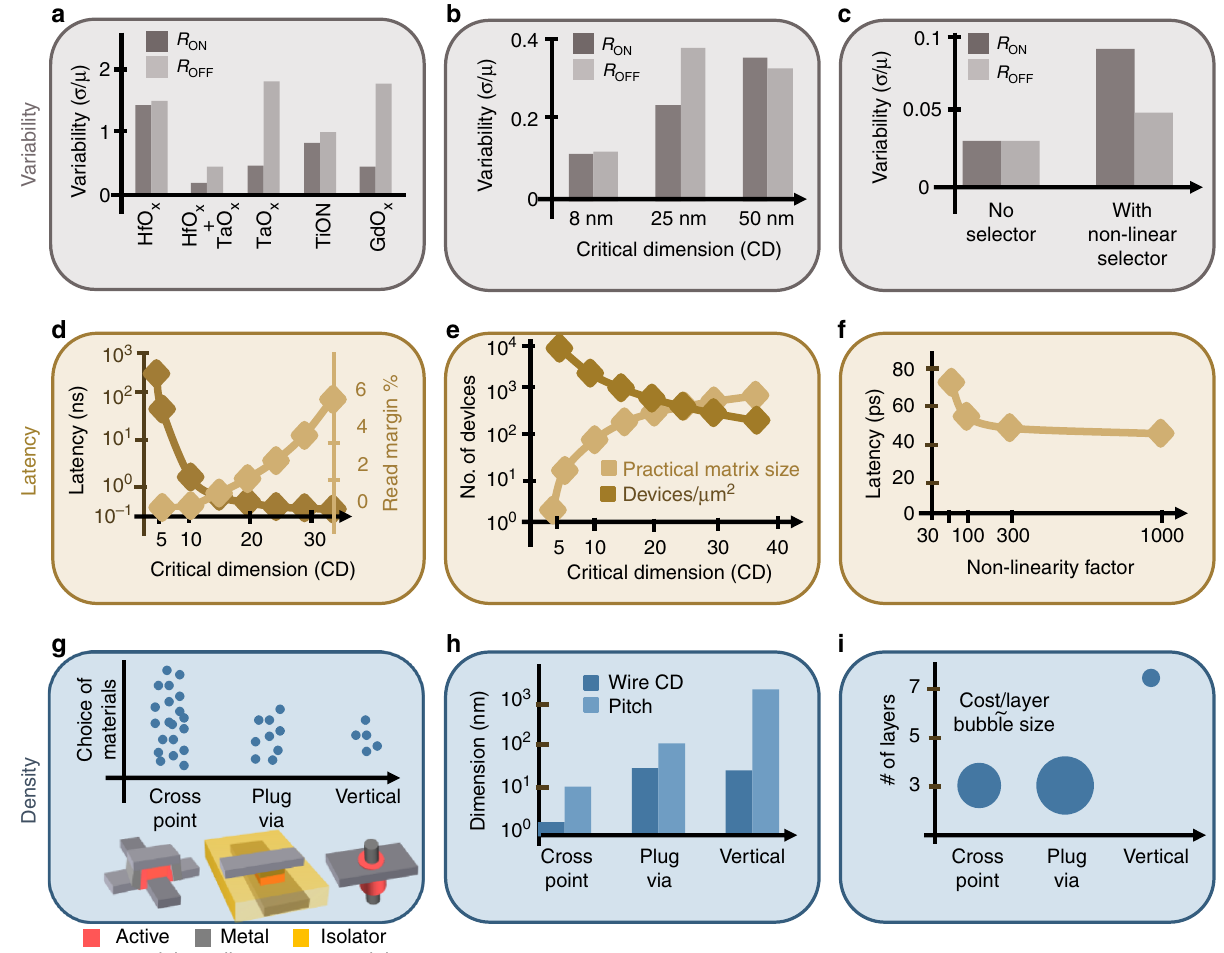
Fig. 1 Matrix-level metrics and manufacturing choices impacting them. a – c Variability metric. The variability is a measure of the spread of device performance (in this example, the two extreme resistance states R ON and R OFF ) in a memristive matrix as de fi ned based on the standard deviation and the means of the resistance distributions ( σ / μ ). The variability of the resistance states R ON and R OFF across a matrix is heavily in fl uenced by a the choice of active material and of the material stack (e.g., single material HfO x vs. bilayer HfO x + TaO x ) 5,12 ; b the device scaling as determined by the smallest feature dimension (also known as critical dimension or CD); 6 and c the presence of a series selector/cell which has its own variability pro fi le 8 . The variability results presented in a – c are extracted from different studies so they have different orders of magnitude depending on the manufacturing process used. d – f Latency metric. The latency is a measure of the delay in accessing the desired device, delay caused by the charging and discharging of the wires. d Impact of the wire downscaling on latency and read margin, which is a measure of the capability to discriminate between the two extreme states ( R ON and R OFF ) of the memristive device 13 . e Practical matrix size limited by latency vs. the density (number of devices in a μ m 2 ) allowed by the critical dimension of the manufacturing process. f The impact of the device / selector non-linearity on latency 14 . g – i Density metric discussed from the perspective of the most common device designs — crosspoint, plug-via and vertical. g The availability of materials suitable for each device design, given aspects such as uniformity, conformal deposition, etc. h The state-of-the-art scalability for each design (crosspoint: 2 nm CD/12 nm pitch 9 , plug-via ~30 nm/100 nm 15 , vertical structure has yet to be optimized for scalability 12 ). i State-of-the-art stackability for each design and its approximate cost per matrix layer (represented by the relative size of the